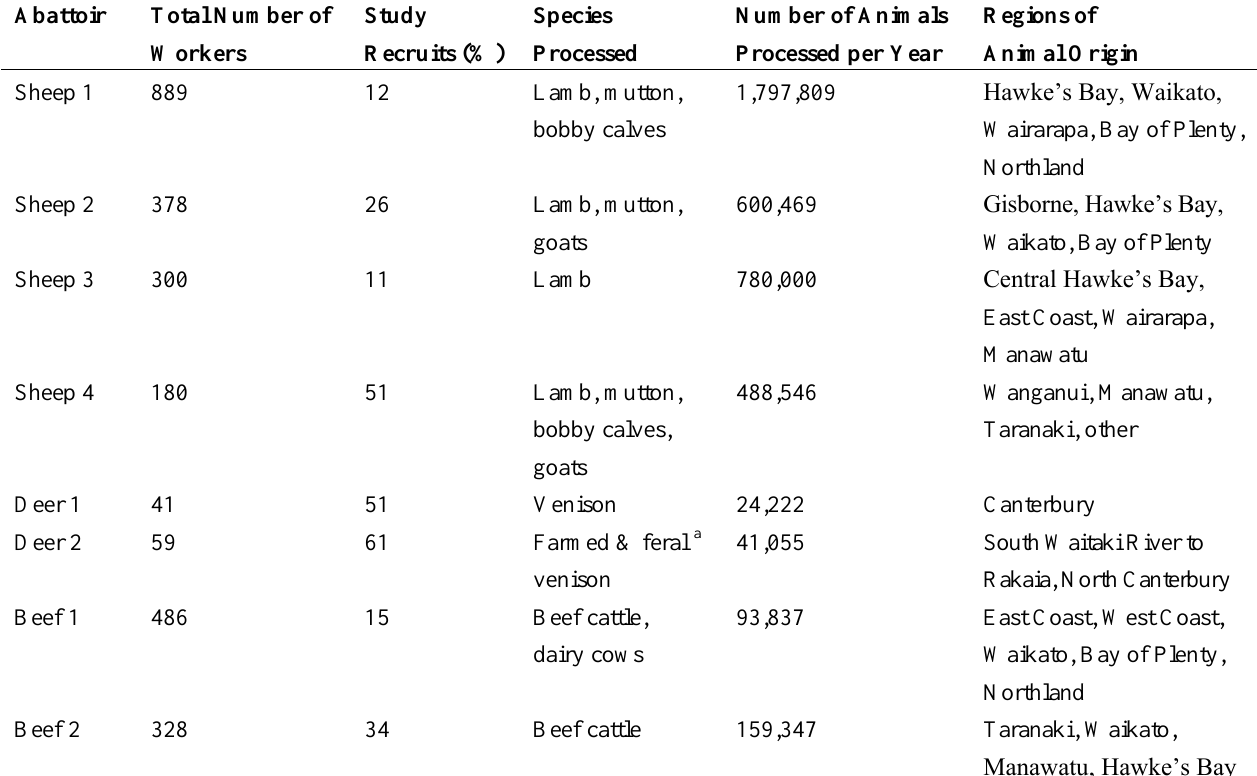
Table 2. Number of workers, proportion recruited for the study, the species and total number processed and the regional origin of animals slaughtered in participating slaughter